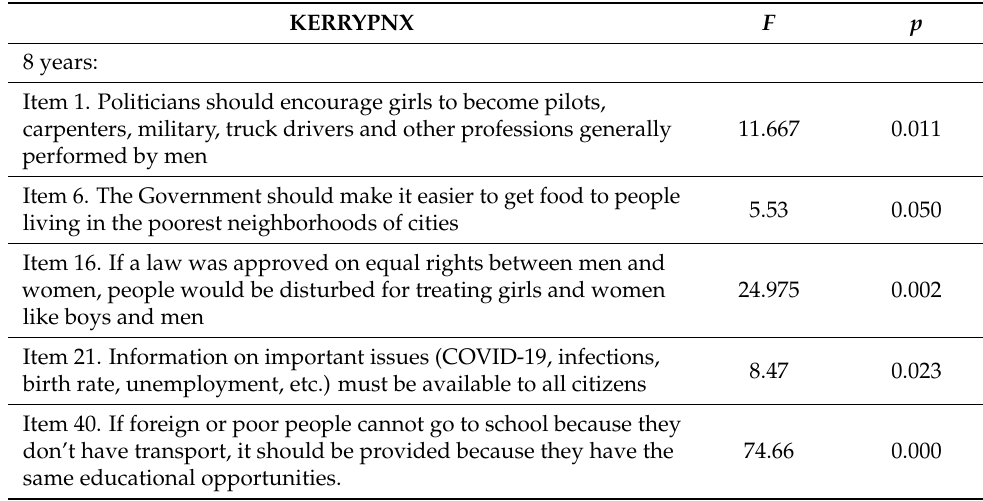
Table 2. Significant intergroup and age differences in the ATHRI